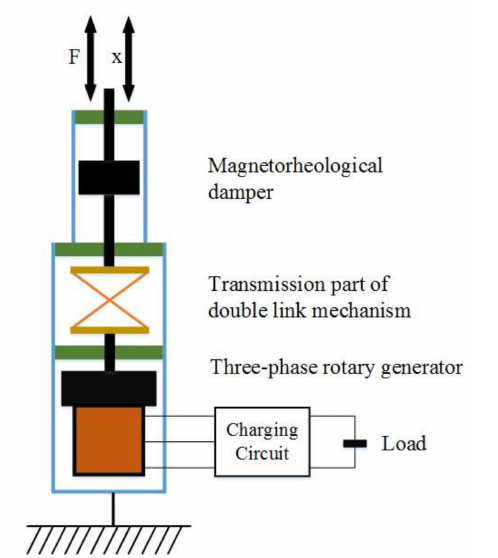
Figure 5. Schematic diagram of the dynamics model of a self-powered MR damper.